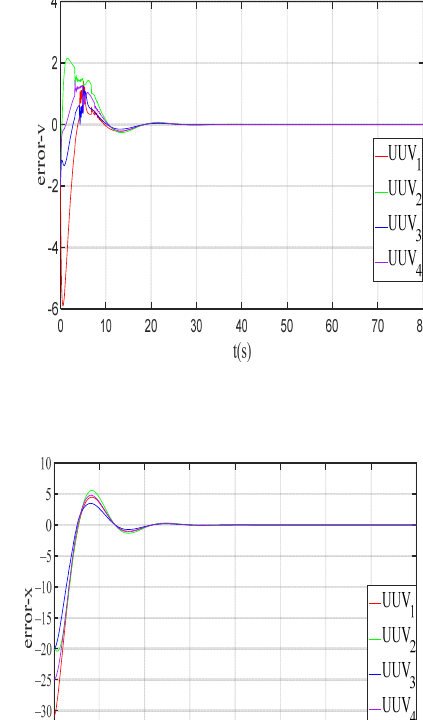
Figure 8. The distance between any two UUVs of the formation without collision avoidance.